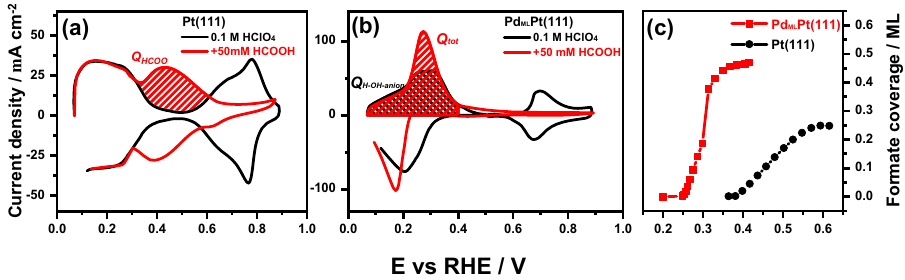
Fig. 2 Determination of formate coverage on Pt(111) and Pd ML Pt(111). Voltammograms of a Pt(111) and b Pd ML Pt(111) electrode in 0.1 M HClO 4 (black line) and 0.1 M HClO 4 + 50 mM HCOOH (red line) solution at a high-scan rate of 50 V s − 1 . c Comparison between the coverage of adsorbed formate as a function of potential on the Pd ML Pt(111) and